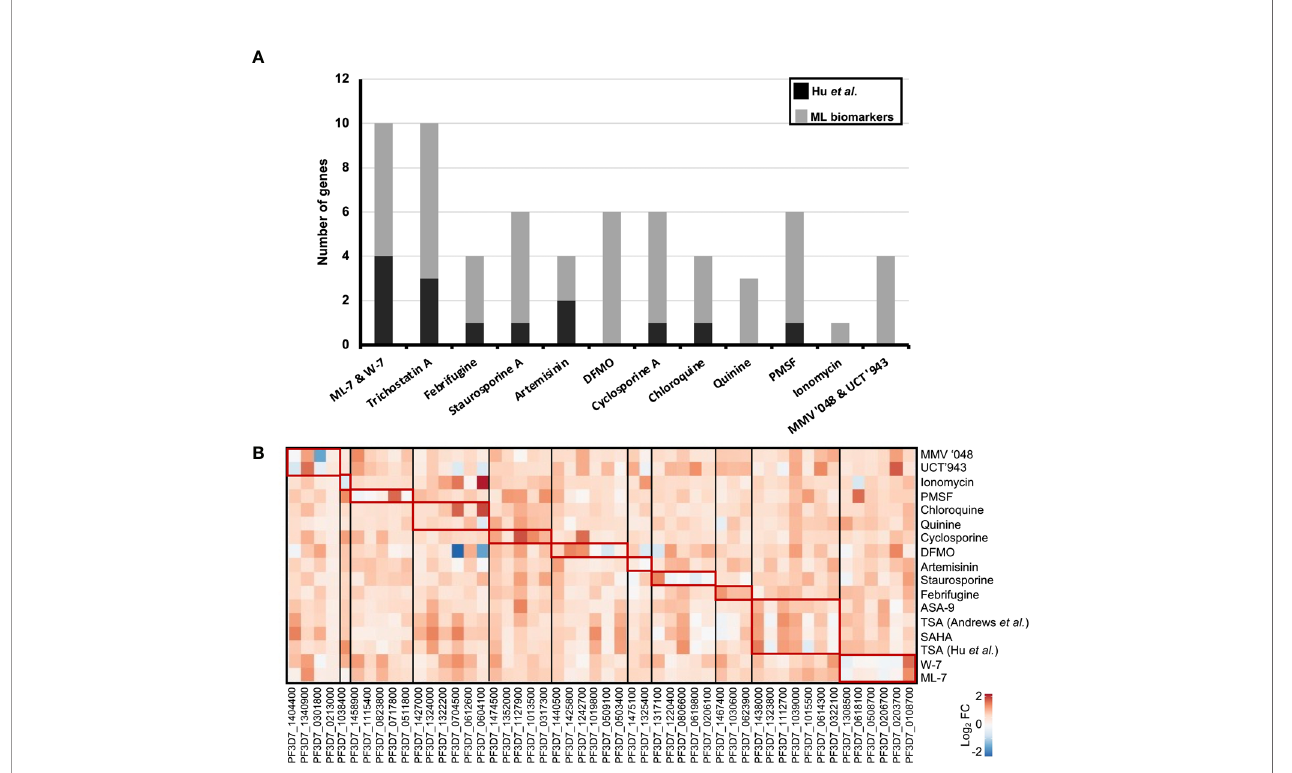
FIGURE 4 | Novelty of 50 rationally selected biomarker transcripts expression patterns associated with similar MoA. (A) The top 50 biomarkers (gray) from the rational selection 50-transcript MLR minimodel were compared to DEGs associated to MoA as identi fi ed by (Hu et al., 2009) shown in black. Biomarker transcripts which were also identi fi ed for the same compound and MoA within these two studies are shown as stacked bars. (B) Correlation in gene expression of the 50 biomarkers between compounds within our database. Log 2 fold change values for each transcript was extracted in all the compound treatments to plot the heatmap. Similar expression patterns (red blocks) are seen within compound treatments with similar MoA. The biomarkers are grouped according to the MoA (black blocks) they were identi fi ed from in Table 1